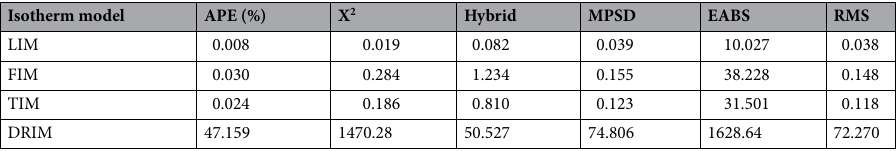
Table 2. In the adsorption of AY11 dye by MBT, a few error function values of the isotherm models were found to be the most closely matched to the experimental equilibrium data.